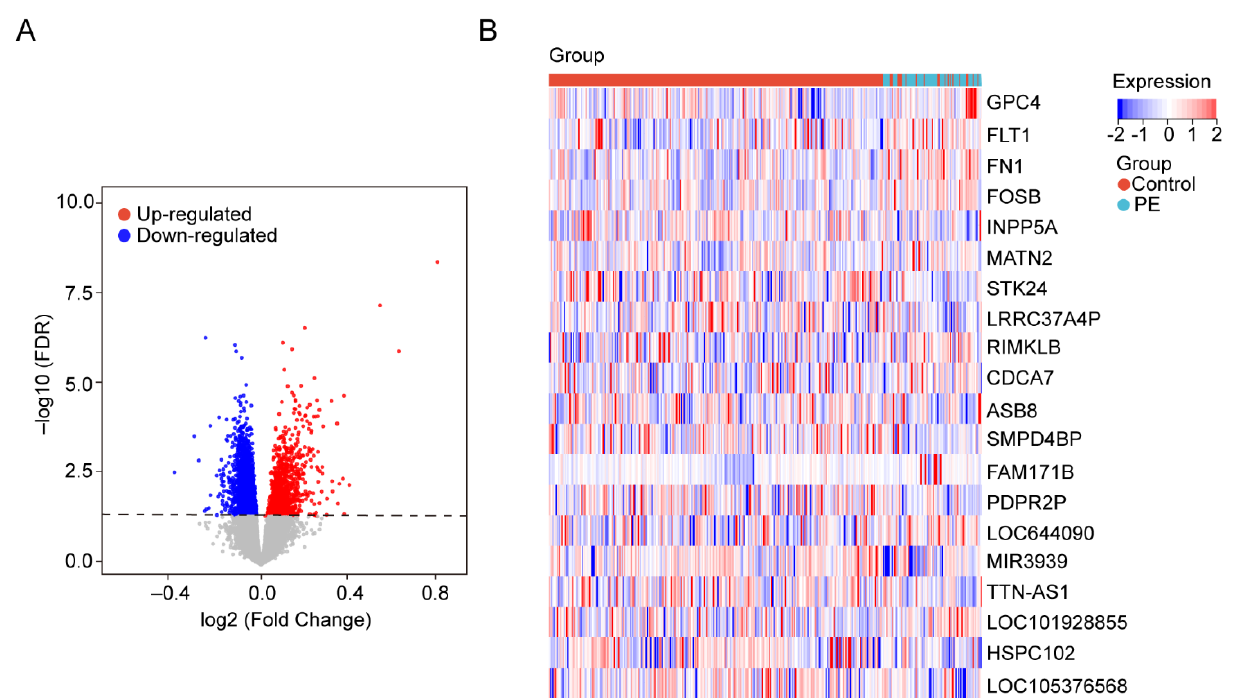
Figure 2. Identification of DEGs in the blood samples. ( A ) The volcanic maps. Red dots represent upregulated genes; blue dots represent downregulated genes, and gray dots represent no significance genes. ( B ) Heatmap for hierarchical clustering of DEGs in the control group and PE group.